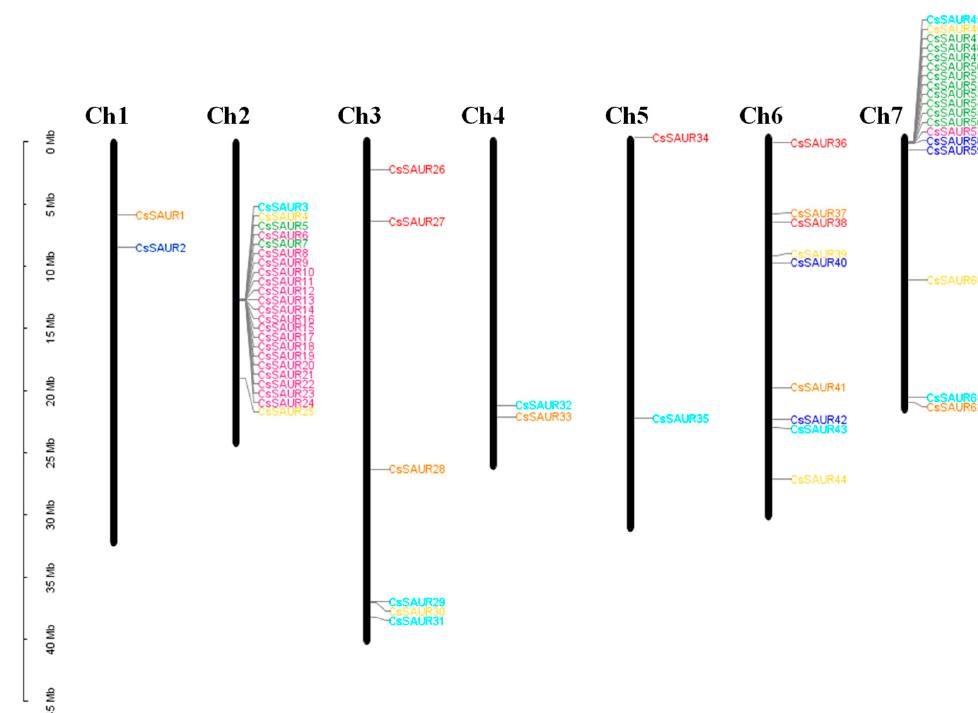
Figure 2. The chromosomal locations of CsSAUR genes. Members of the same group are presented in the same color. The provided scale is in centimorgans (Mb).